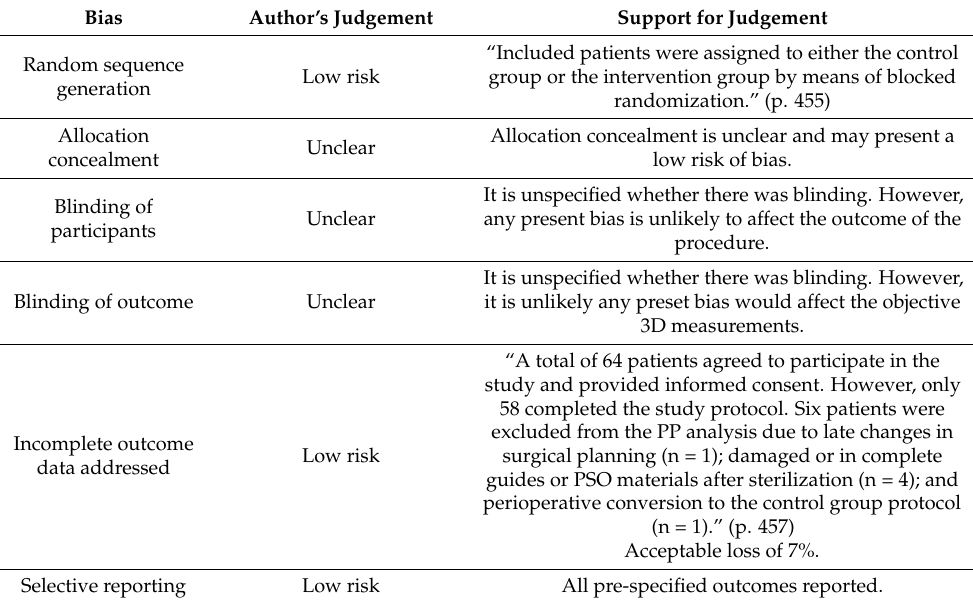
Table A3. Risk of bias analysis of Kraeima et al. (2020) using Cochrane Collaboration’s risk of bias